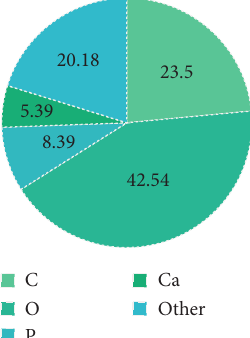
Figure 4: Element composition of urine nanocrystalline in a representative